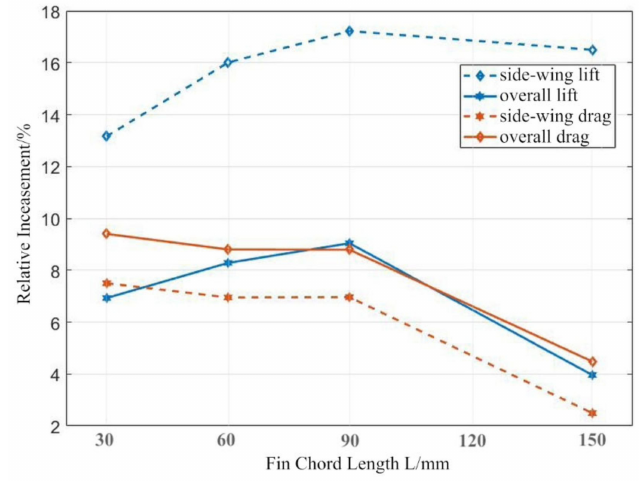
Figure 14. Influence of chord length L to side wing aerodynamic performance.